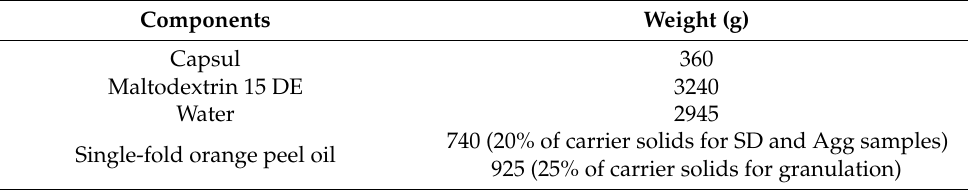
Table 1. Components of the orange oil emulsion used for